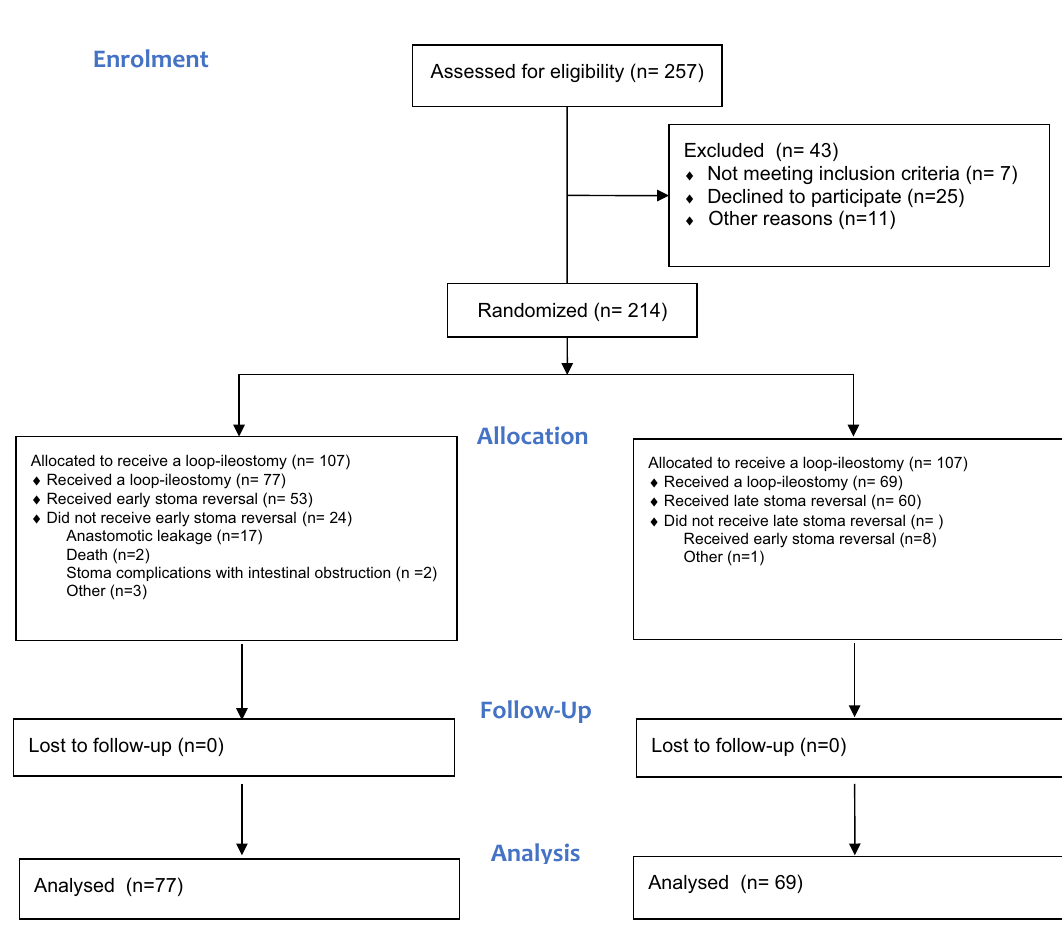
Figure 1. CONSORT flow diagram for enrolment, allocation and